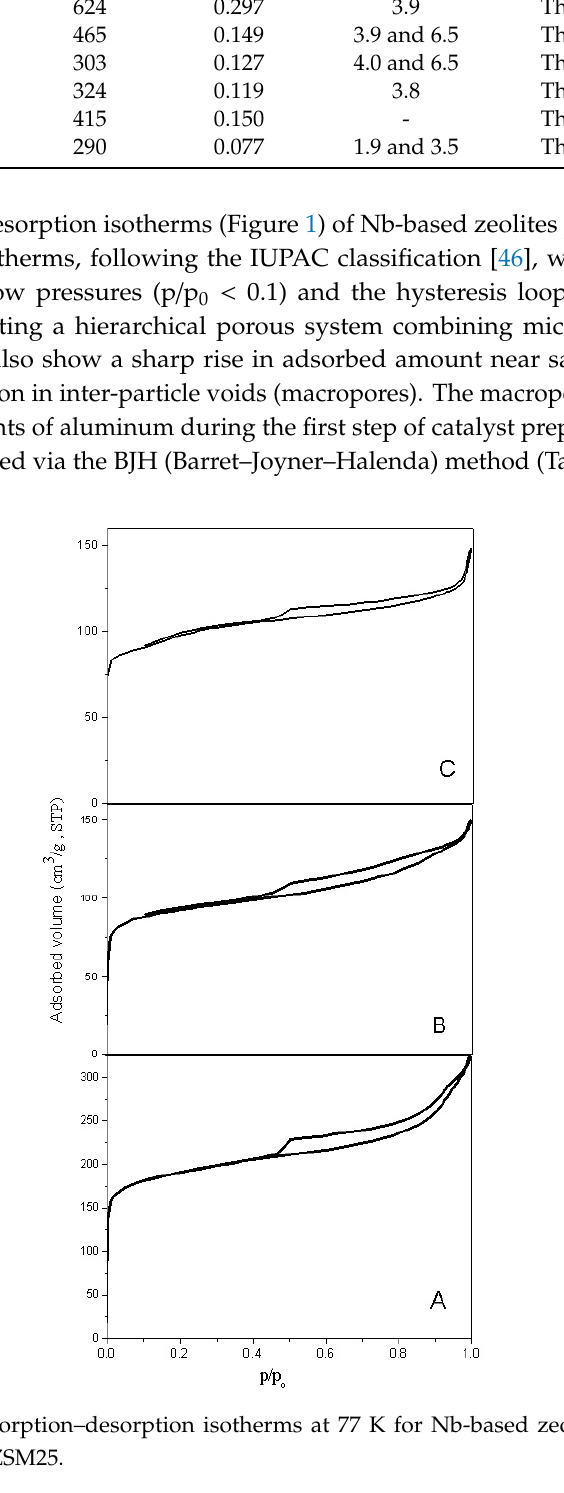
Figure 1. Nitrogen adsorption–desorption isotherms at 77 K for Nb-based zeolites: ( A )—Nb-Y5, ( B )— Nb-Y30, ( C